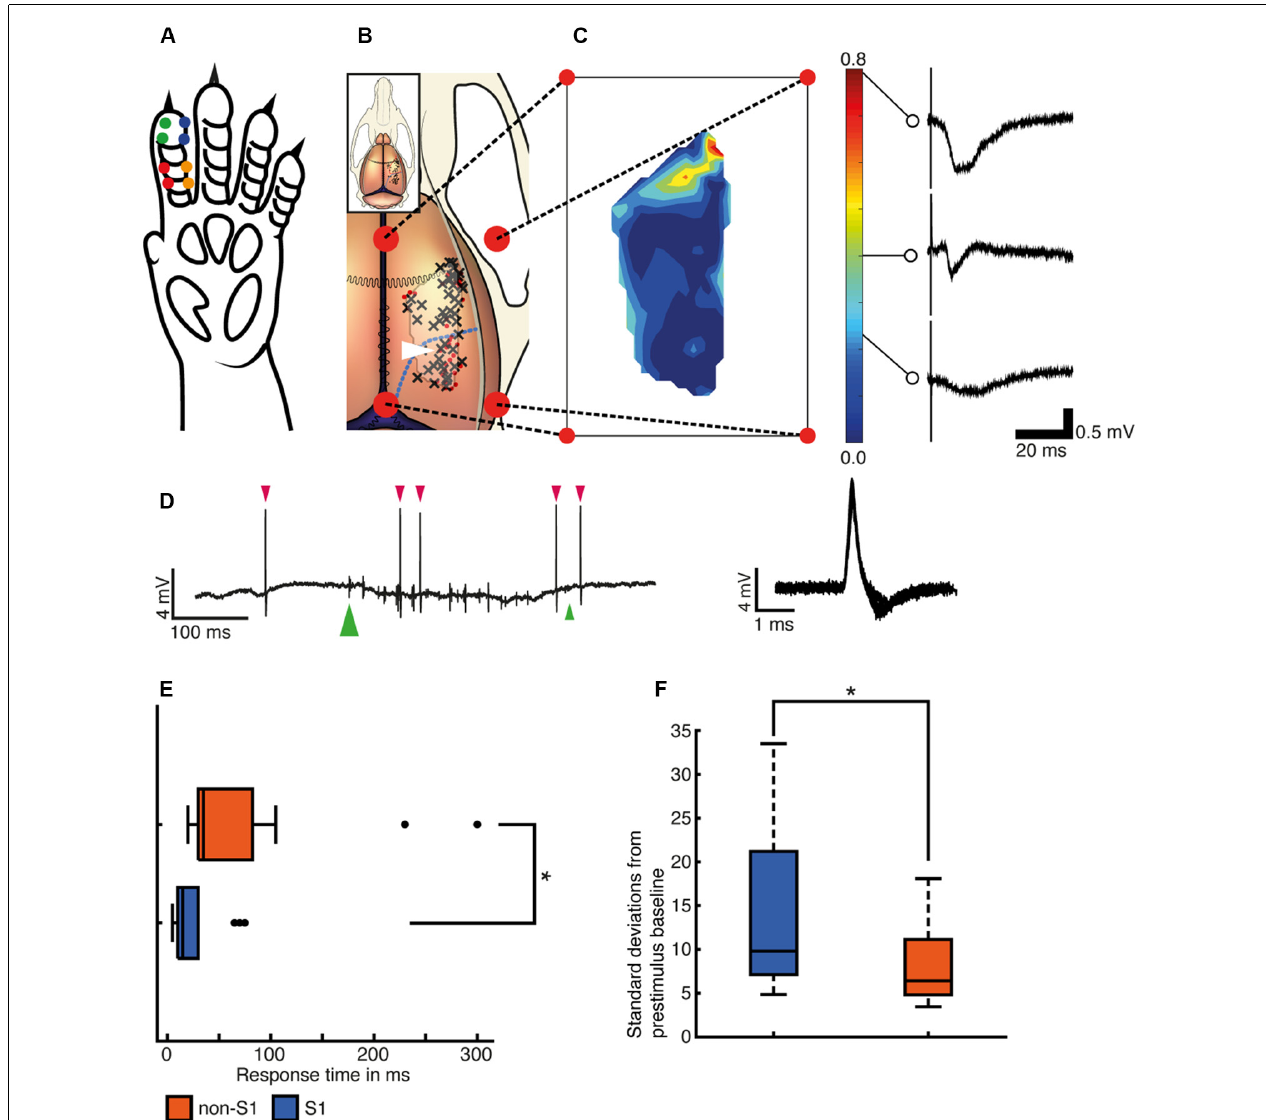
FIGURE 1 | Recording sites and responses to single pulse stimulations. (A) Illustration of the left forepaw of the rat to indicate the locations of needle electrode pairs (colored dots) used for the delivery of the tactile afferent stimuli. (B) Illustration of the rat brain and skull. Black crosses ( N = 45) indicate electrode tracks/recording sites with at least one neuron with valid decoding of the tactile input patterns (see text) and red dots ( N = 33) indicate sites without any such neurons. Blue dashed line indicates the border of the visual cortical regions (Papathanasiou et al., 2006; Paxinos and Watson, 2006). The outline of the contour plot in panel (C) is indicated as a lighter area with a dark border for reference. (C) Contour plot of the amplitude of the local field potentials evoked using single pulse stimulation in each of the recording sites. The color calibration bar is shown together with example sensory-evoked local field potentials (SE-LFPs) for three different amplitudes. (D) Left, an example of a raw spike recording during the presentation of stimulation pattern F5. Neuronal spikes are marked with red arrowhead above. The onset of the stimulation pattern is marked with a green large arrowhead below and its termination time is marked with a small green arrowhead. Right, 60 spikes from the example recording are shown superimposed, centered on peak amplitude. Note that the patch clamp electrode allows highly isolated recordings very close to single neurons, which typically results in large spike amplitudes and somewhat wider spikes than with metal microelectrodes. (E) Distribution of the onset latency times for the spike responses evoked by the stimulation patterns (S1 N = 26, non-S1 N = 13). Asterisk indicates that the differences were statistically significant (two-sided Wilcoxon rank sum test, p = 5.5051e-04). (F) Maximal amplitudes for spike responses evoked by the stimulation patterns indicated as multiples of the standard deviation (SD) of the baseline activity (S1 N = 26, non-S1 N = 13). Two outliers in the “somatosensory” group (at 52.8 and 148.4 SDs) were not included to facilitate comparison between the two groups.